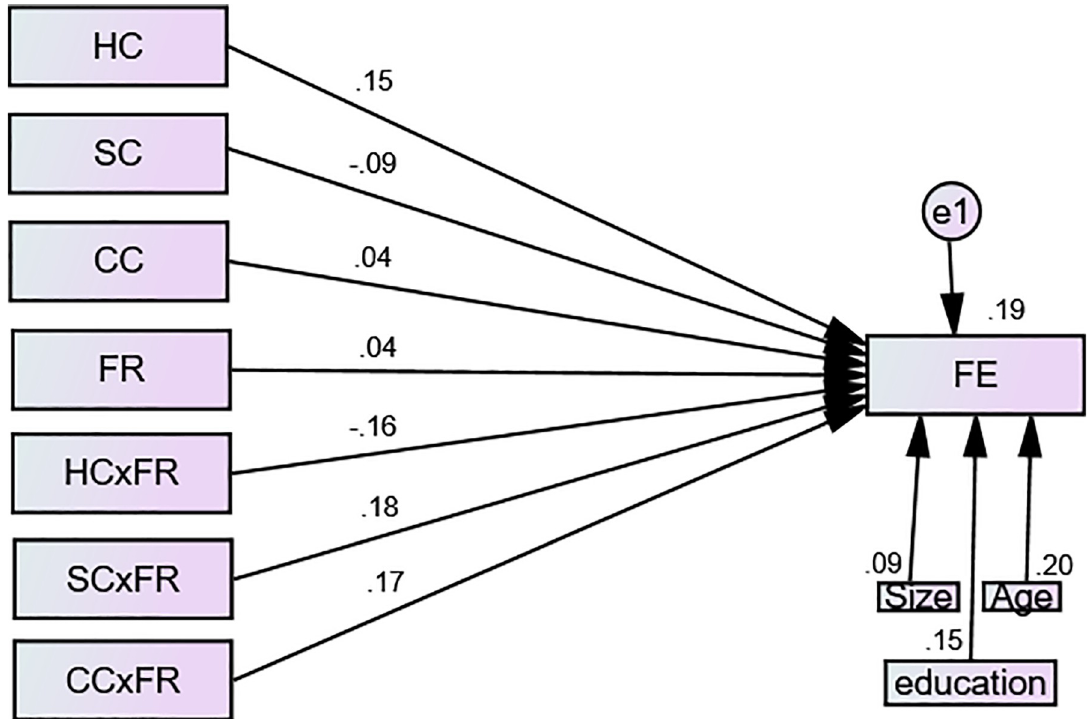
Fig 3. Structural model. FE = Firm Efficiency, HC = Human Capital, SC = Structural Capital, CC = Customer Capital, FR = Financial Resources.